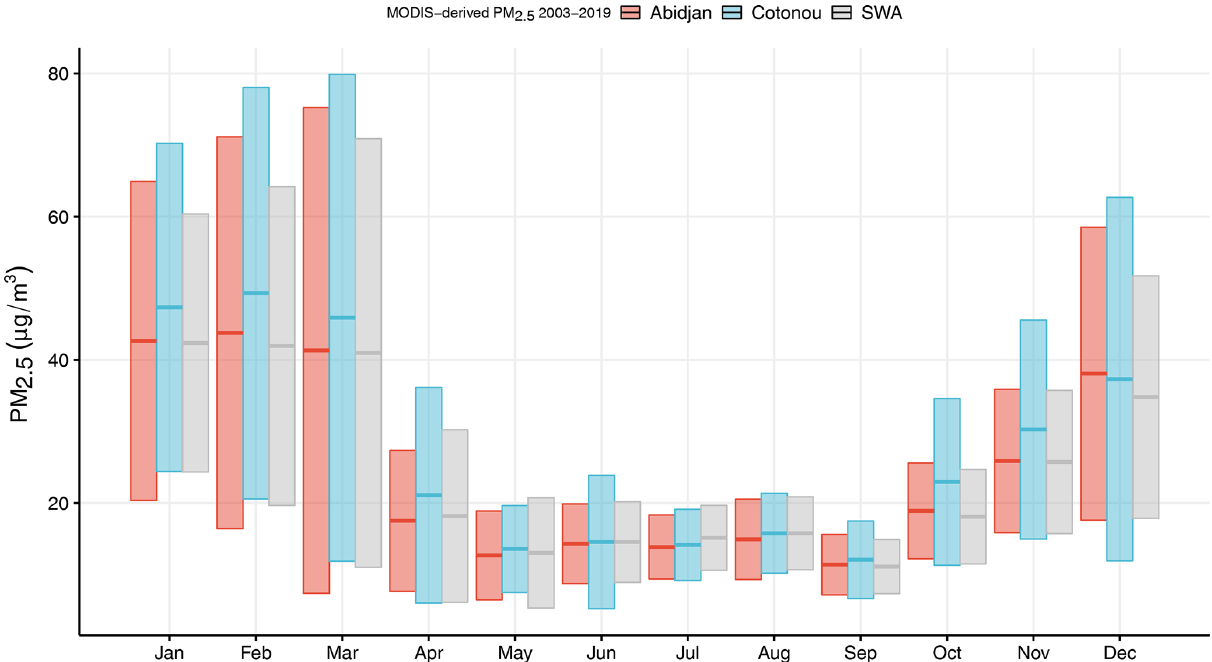
Figure 10. Monthly mean annual cycle of MODIS-derived PM 2 . 5 in Abidjan and Cotonou and the SWA area between 2003 and 2019. Boxes represents the mean ± 1 standard